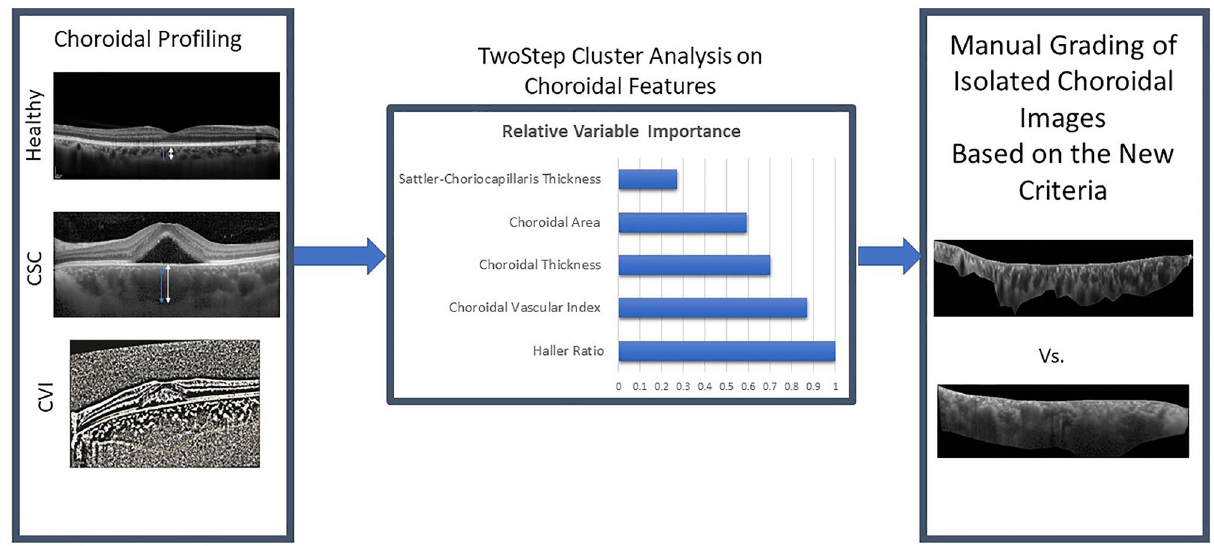
Figure 1. Schematic overview of the study design. Different choroidal features such as choroidal thickness, the thickness of haller ratio and choroidal vascular index (CVI) in central serous chorioretinopathy (CSC) patients and healthy subjects were extracted from OCT images and used in TwoStep cluster analysis. Afterwards, based on the relative variable importance (RVI) index of the cluster analysis, new clinical criteria were developed for diagnosis of pachychoroid. Two retina specialists were asked to label the isolated choroidal images based on these new